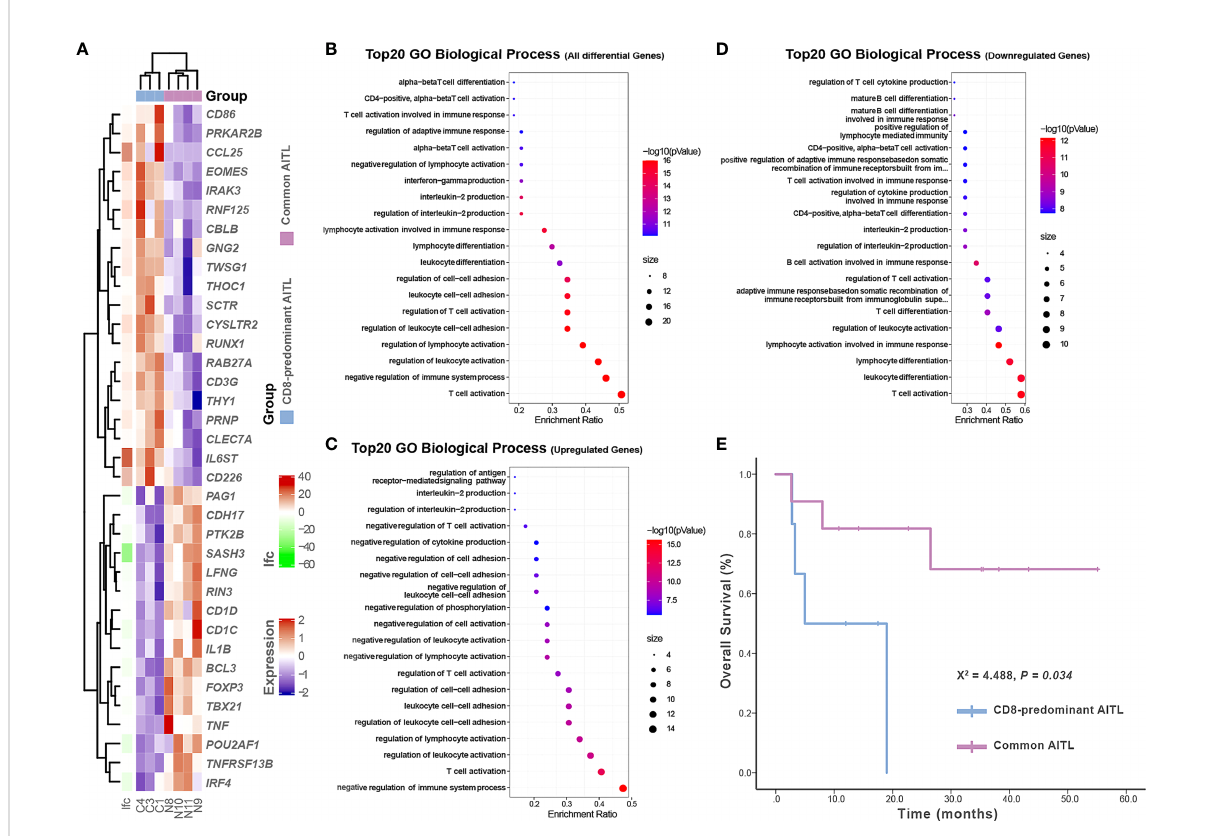
FIGURE 5 Gene expression pro fi les and survival analysis in CD8-predominant AITLs and matched common AITLs. Heatmap analysis showed differences in in fl ammation and immune response-related gene expression between CD8-predominant AITLs and common AITLs (A) . The top 20 enriched biological processes in gene oncology from all differential genes (B) , upregulated differential genes (C) , and downregulated differential genes (D) . Kaplan – Meier estimates of overall survival rate for CD8-predominant AITL and matched patients with common AITL (E)